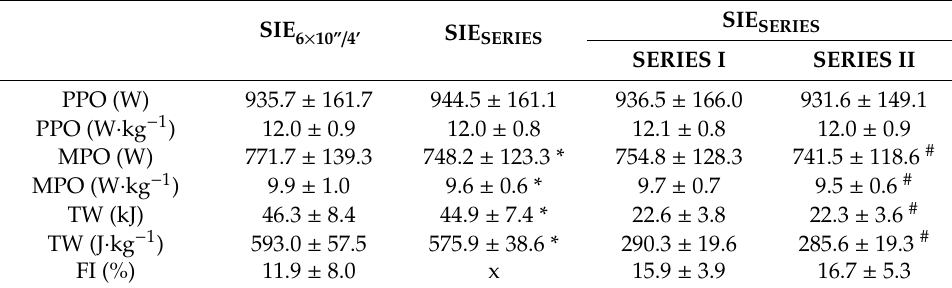
PPO—peak power output; MPO—mean power output; TW—total work; FI—fatigue index; *—statistically significant di ff erence between SIE protocols ( p < 0.05); # —statistically significant di ff erence between SERIES I and SERIES II in SIE SERIES ( p <